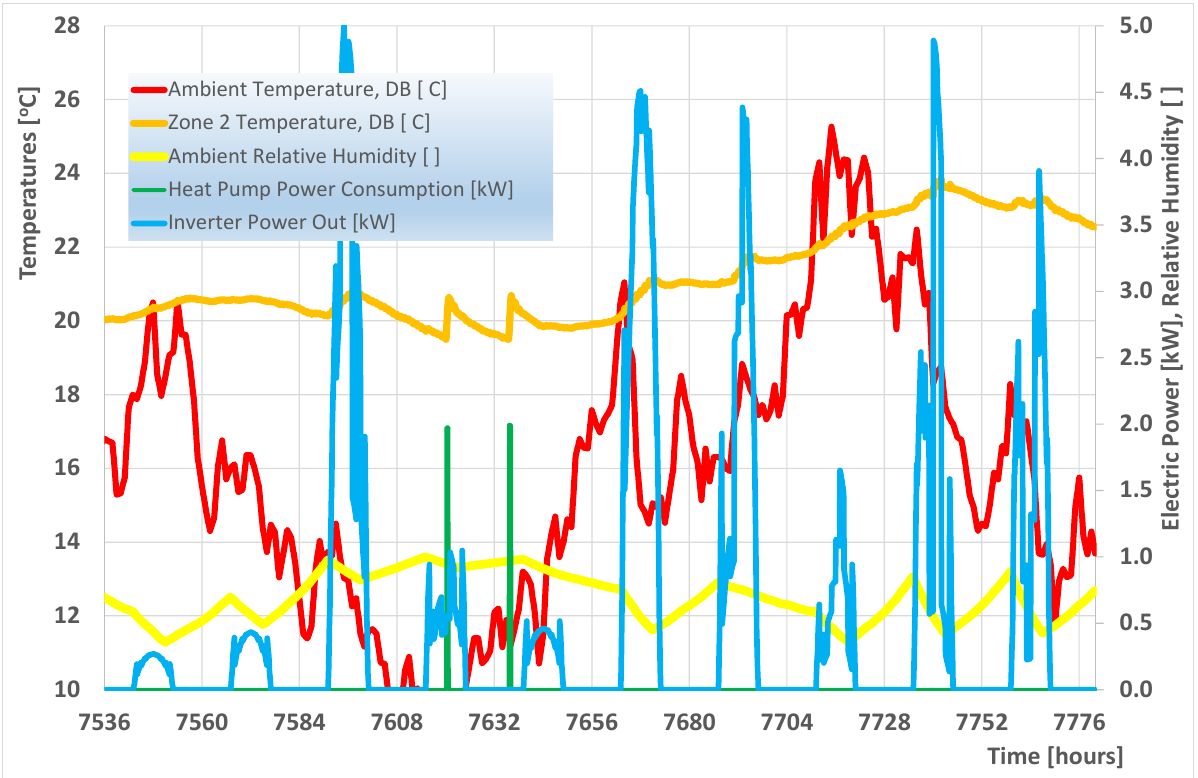
Figure 5. Transient performance of the system during 10 days in mid-October. Room thermostat, which controls heat pump operation, is set to 20 °C. PV panels tilt angle is 30°.